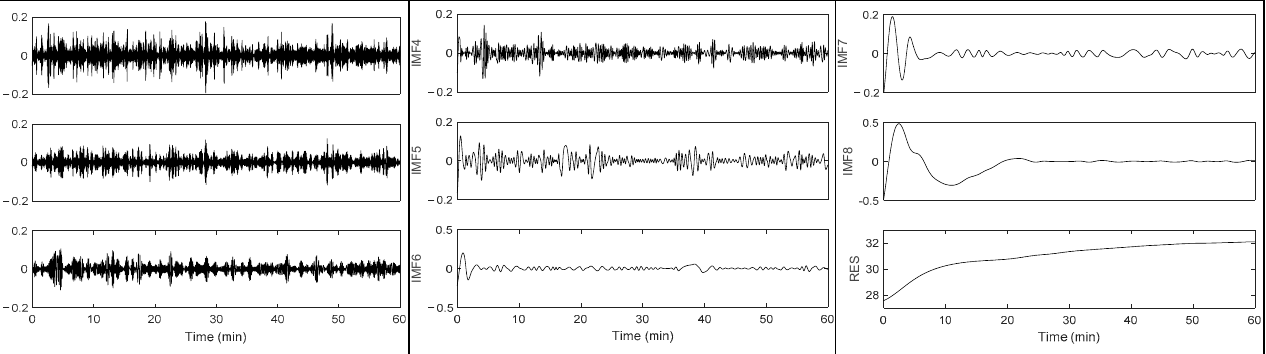
Figure 4. Decomposed components of the original IRs signal. The first eight components (IMF1 to IMF8) were intrinsic mode functions, while the last one (RES) at the bottom right was the residue. The horizontal axis represents the whole sitting period (one-hour epoch of a randomly selected NCTM trial), while the vertical axis represents the temperature values ( °C) .